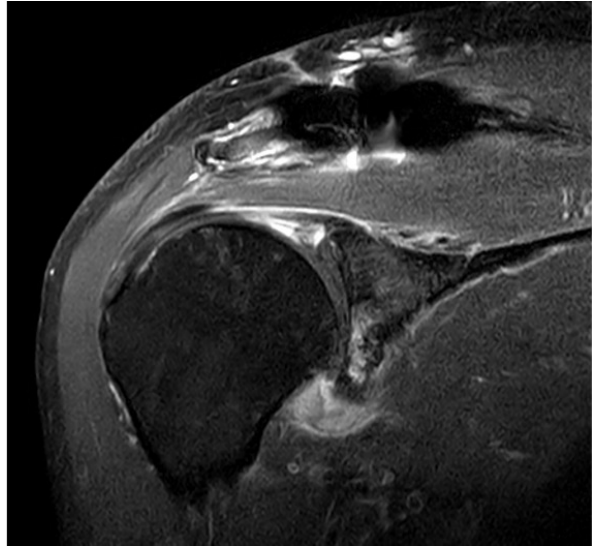
Figure 1. Typical findings on magnetic resonance imaging (MRI) in patients with painful shoulder stiffness. High signal intensity is observed in thickened joint capsule, which is emphasized on axillary capsular pouch.